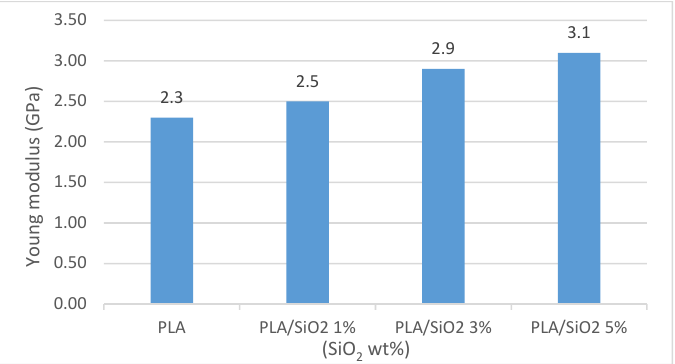
Fig 4. Comparison of Young module for poly lactic acid films containing silicon dioxide nanoparticle